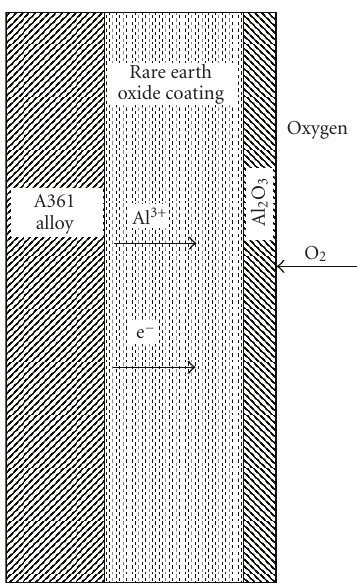
Figure 7: Scheme of transport of reacting species in the formation of the Al 2 O 3 film on the rare earth oxide coating.